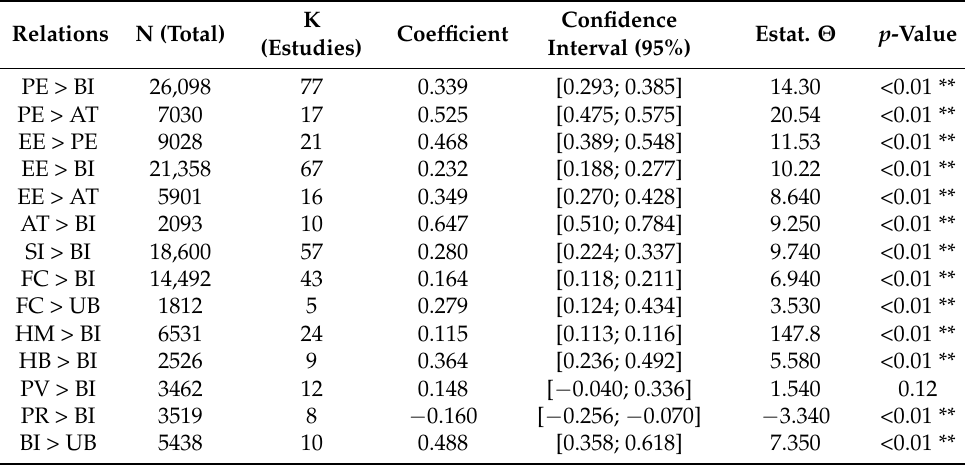
Table 3. Effects corresponding to the main variables of the